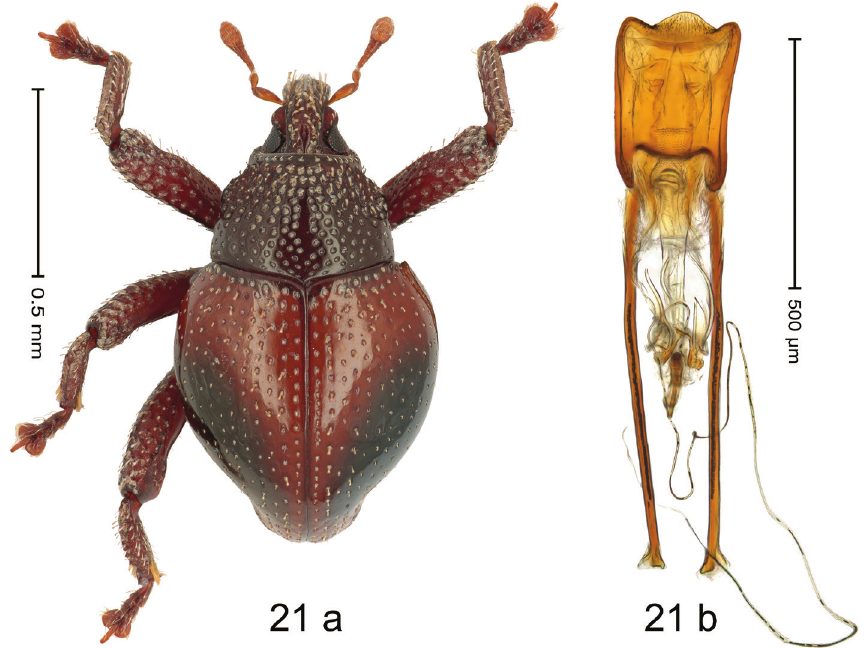
Figure 21. Trigonopterus sarinoi sp. nov., holotype a habitus b